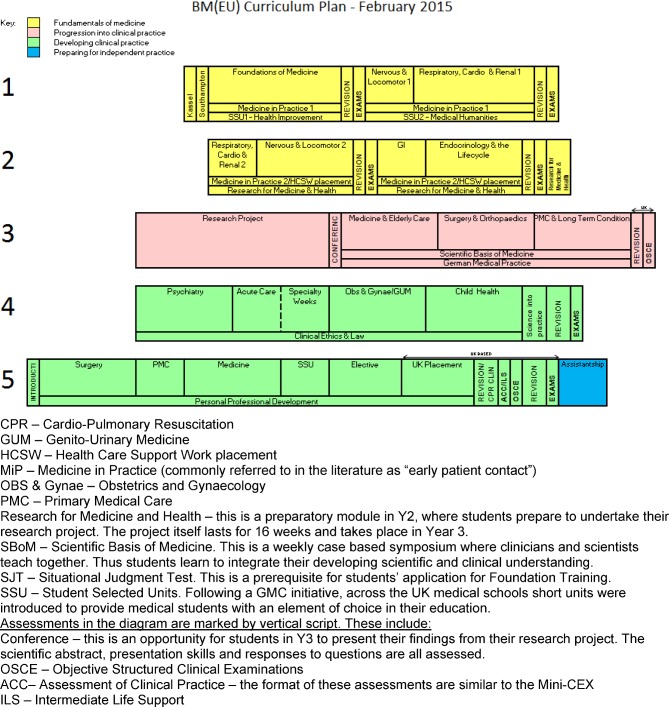
BM5 curriculum map